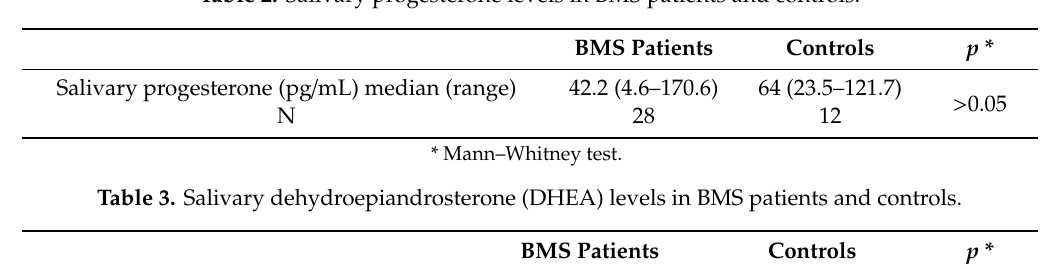
Table 2. Salivary progesterone levels in BMS patients and controls.